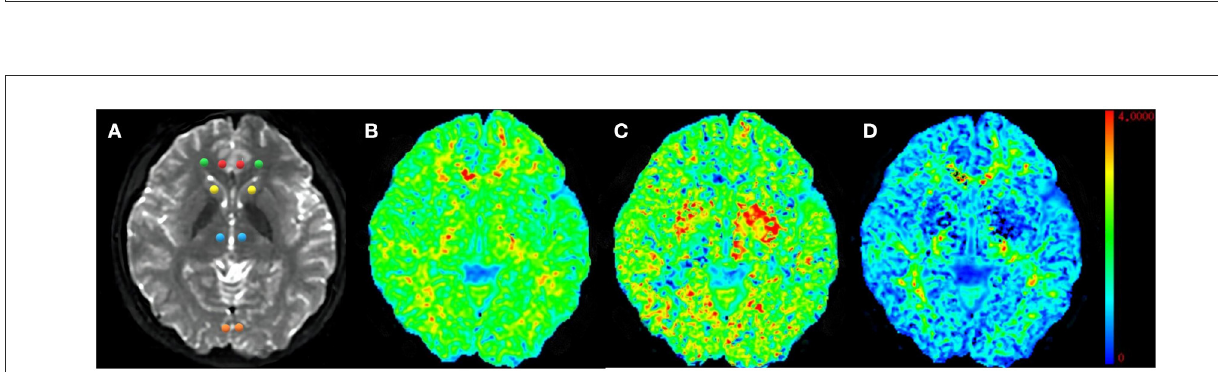
FIGURE2 Representative region of interest (ROI) for diffusion kurtosis imaging (DKI) parameters. Raw map of DKI (A) , mean kurtosis (MK) map (B) , axial kurtosis (Ka) map (C) , and radial kurtosis (Kr) map (D) . All regions of interests were localized at the axial raw map. The red circle–anterior cingulate cortex (ACC), the orange circle–posterior cingulate cortex (PCC), the green circle–ventral prefrontal white matter (VPWM), the yellow circle–basal ganglia (BG), the blue circle–thalamus